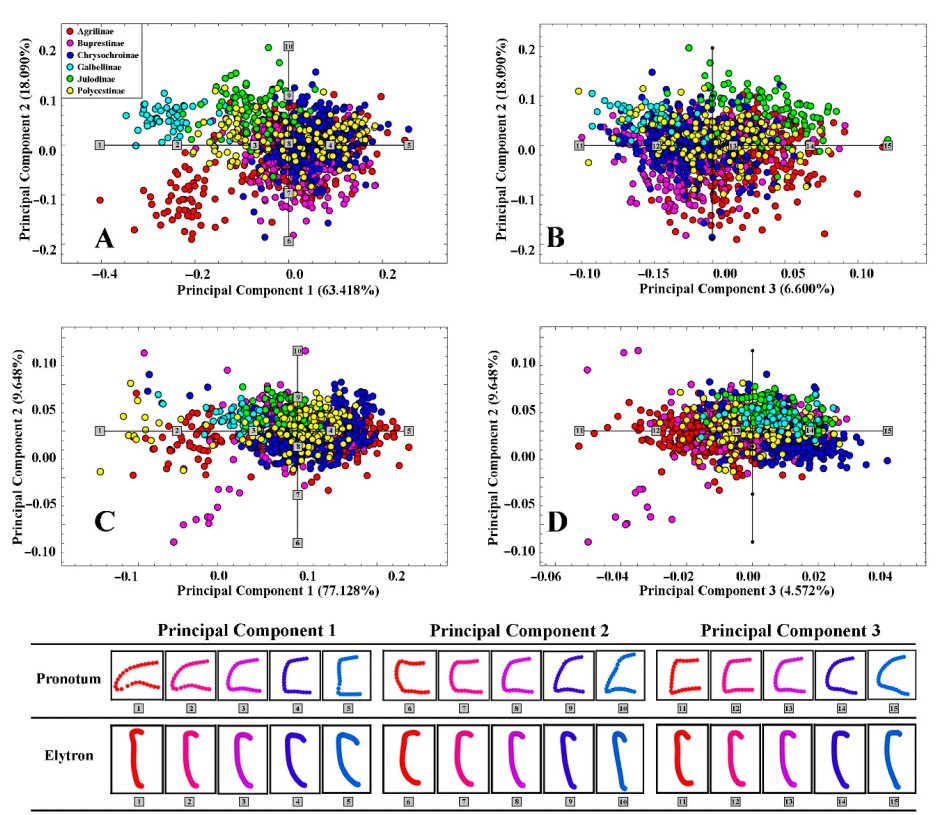
Figure 3. Distribution of subfamilies based on the morphological variation of test traits along principal component axes. Overall, 88.109%/91.348% of observed shape variation was represented by the first three principal components (PCs) in the pronotum and elytron tests, respectively. ( A ): Deformation trend of the pronotum along PC1 and PC2. ( B ): Variation of the pronotum along PC2 and PC3. ( C ) : Variation of the elytron along PC1 and PC2. ( D ): Variation of the elytron along PC2 and PC3. All the deformations were showed as shape models in the blocks under the PC-space pictures. Each shape model of variation was calculated at equally spaced intervals along PC axes with coordinates for individual shape model calculations indicated by marks and numbers in the two-dimensional PC shape spaces.